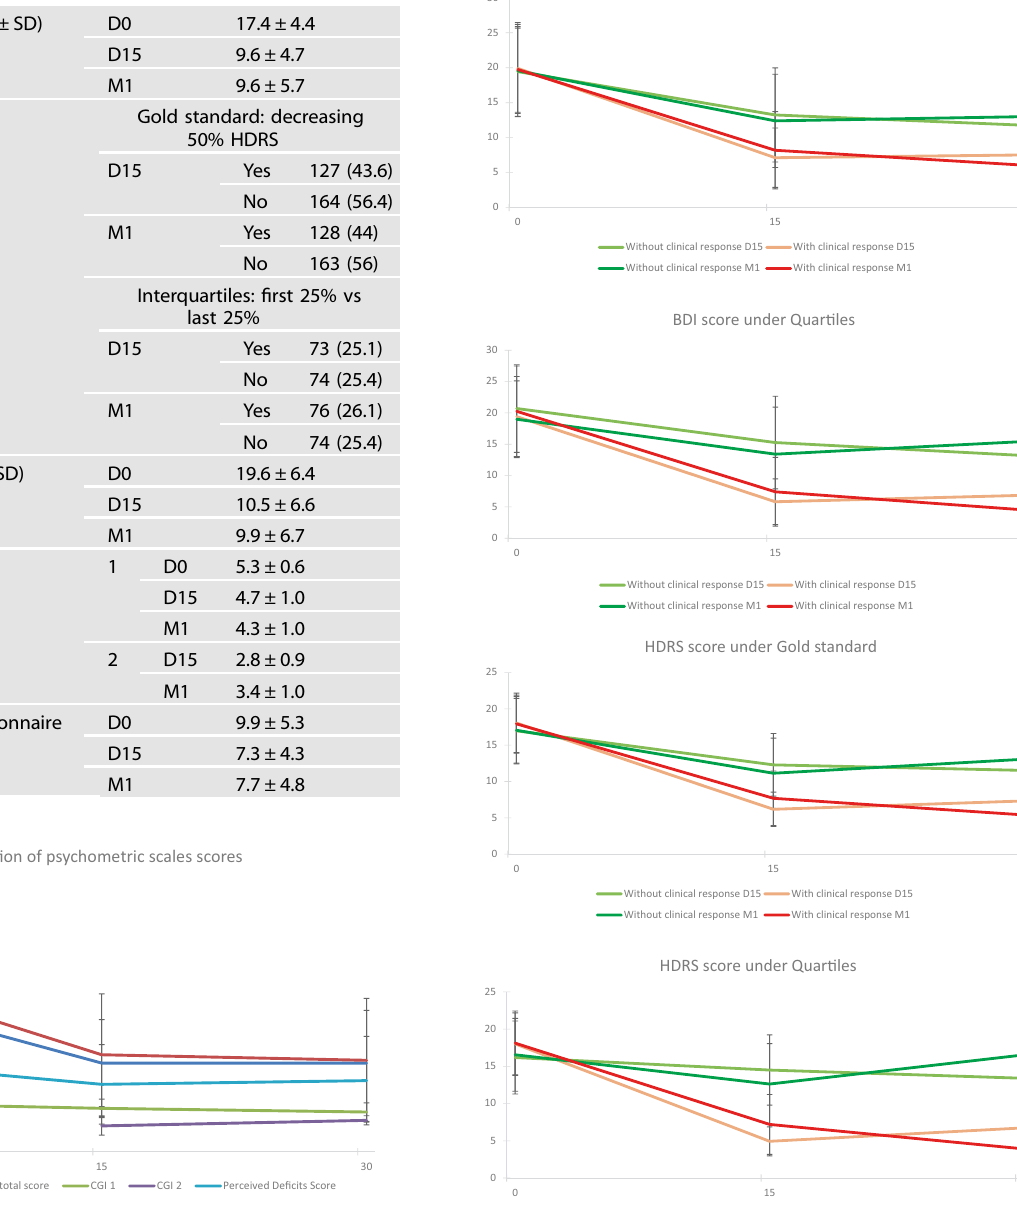
Fig. 2 Evolution of psychometric scales scores from D0 to M1.